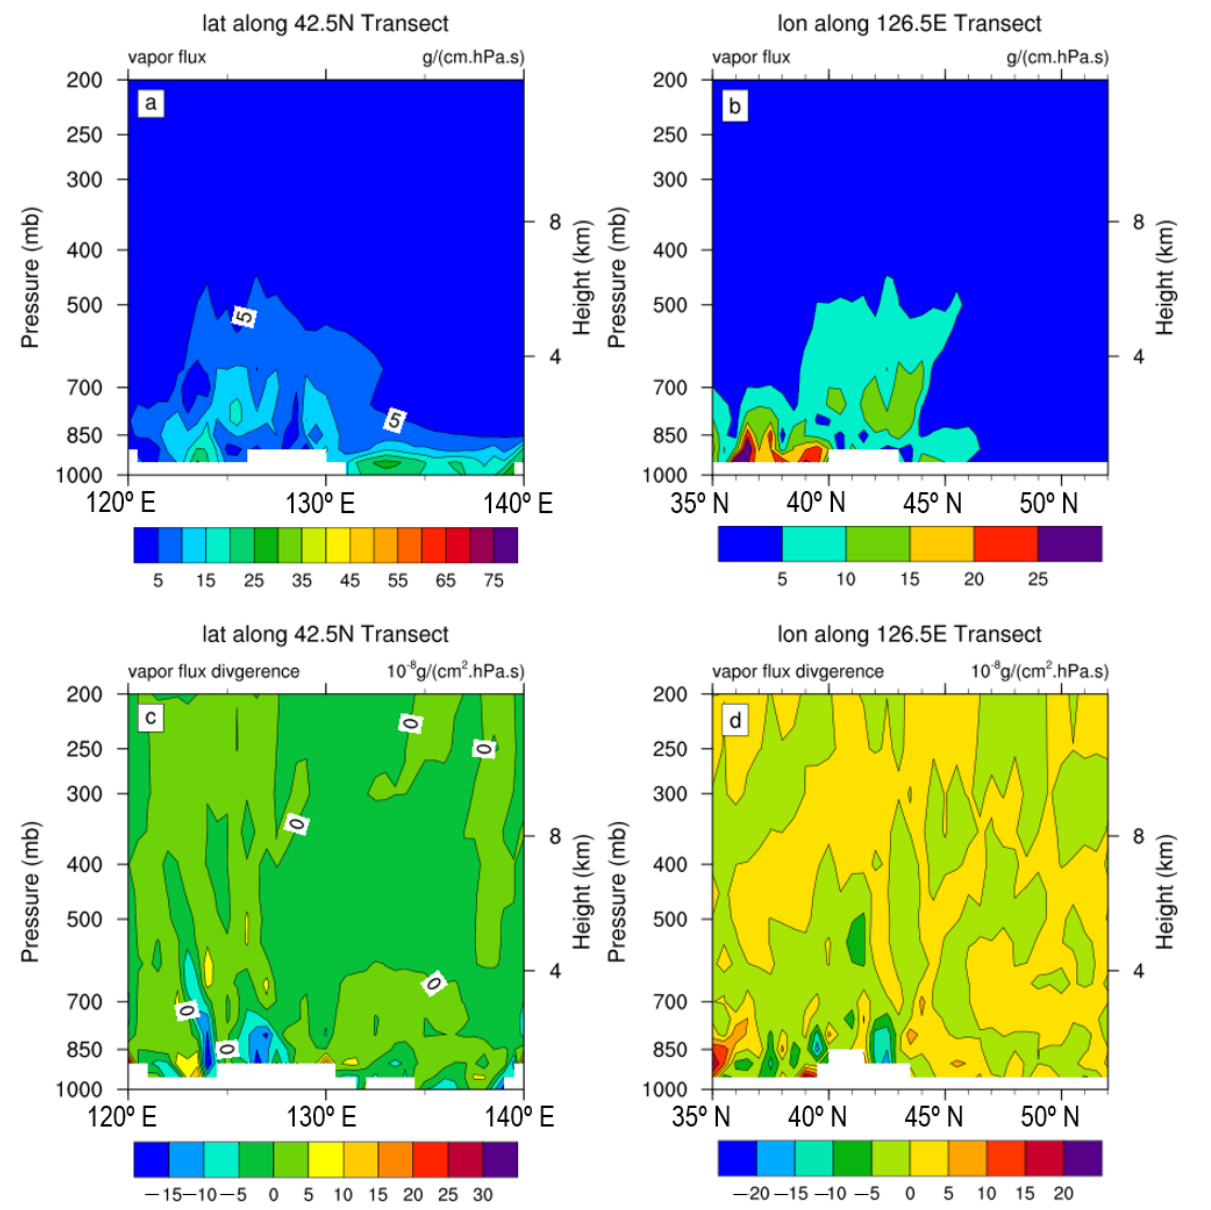
Figure 7. Vertical cross section of vapor flux (shaded; g/(cm.hPa.s)) along 42.5° N ( a ), and 126.5° E ( b ) at 19 UTC on 14 August 2019; Vertical cross section of water vapor flux divergence (shaded; 10 −8 g/(cm 2 .hPa.s)) along 42.5° N ( c ), and 126.5° E ( d ) at 19 UTC on 14 August 2019.